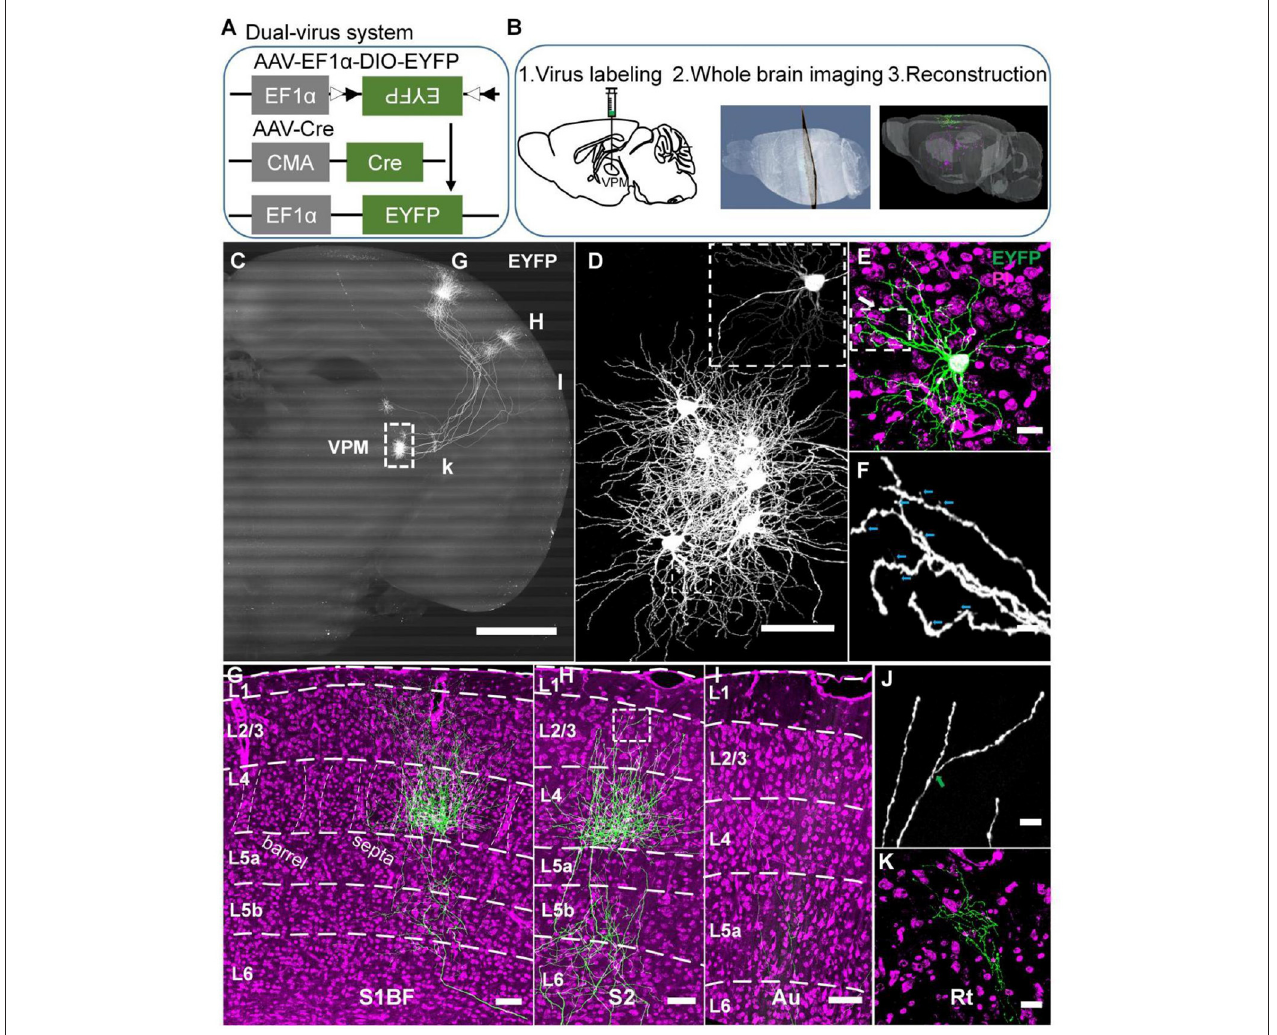
FIGURE 1 | A strategy for achieving complete morphologies of individual VPM neurons. (A) Schematic diagram of the dual-virus system. (B) Procedures to obtain individual VPM neurons. Step 1, virus injection in VPM; step 2, slicing and imaging brain with CSFT system; step 3, neuron reconstruction. (C) The overall projection of VPM neurons in the whole brain. The axons project to RT, S1BF, S2, and Au. 800- µ m max-intensity projection. (D) The VPM cell bodies. The amplification from the white dashed box in (C) . (E) Morphology of VPM dendrites. Amplification of EYFP channel image from the white dashed box in (D) . Five- µ m max-intensity projection. Green: 300- µ m max-intensity projection. (F) Distal dendrites of VPM neuron including closely dendritic excrescences and spines. The amplification from the white box in (E) . Cyan arrows represent spines. (G) Laminar distribution of VPM axons in S1BF. White dashed curves in layer 4: the borders between barrels and septa. (H) Laminar distribution of VPM axons in S2. (I) Laminar distribution of VPM axons in Au. (J) Remote VPM axons. Amplification of EYFP channel image from the white box in (H) . Green arrow: branch point. (K) VPM axons in Rt. Scale bar: 1,000 µ m (C) ; 100 µ m (D) ; 100 µ m (E) ; 25 µ m (F) ; 200 µ m (G–I) ; 20 µ m (J) ; 50 µ m (K) . Purple: PI channel image (E,G–I,K)